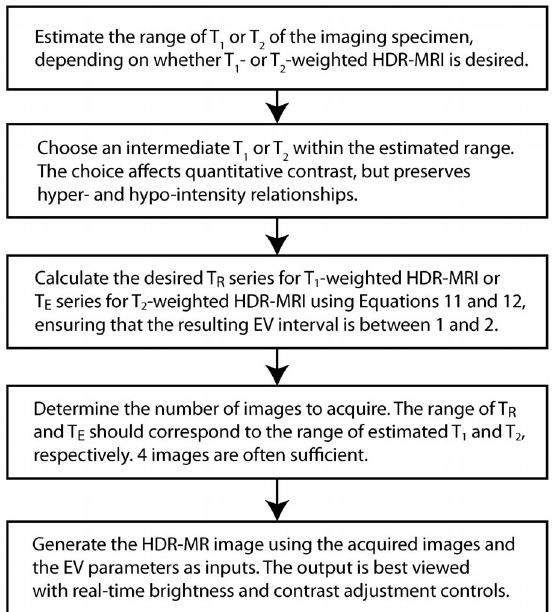
Figure 8. Recommended protocol for HDR-MRI when utilizing a commercial